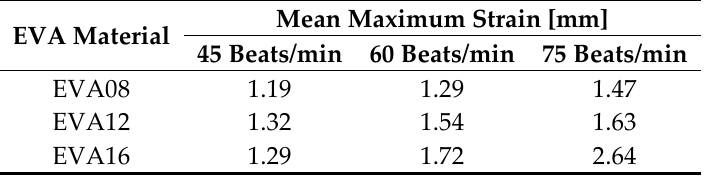
Table 2. Measured mean maximum strains for different EVA materials and gait